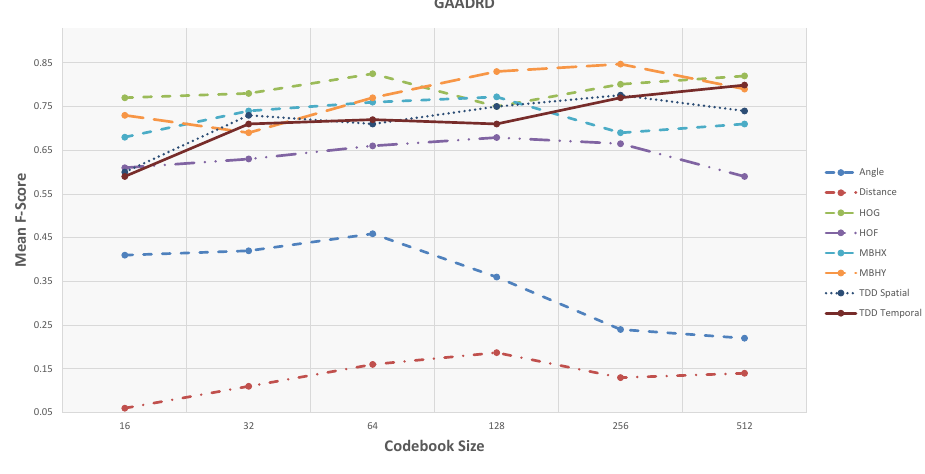
Figure 8. Shows F-Score values of the unsupervised framework w.r.t. codebook size on GAADRD